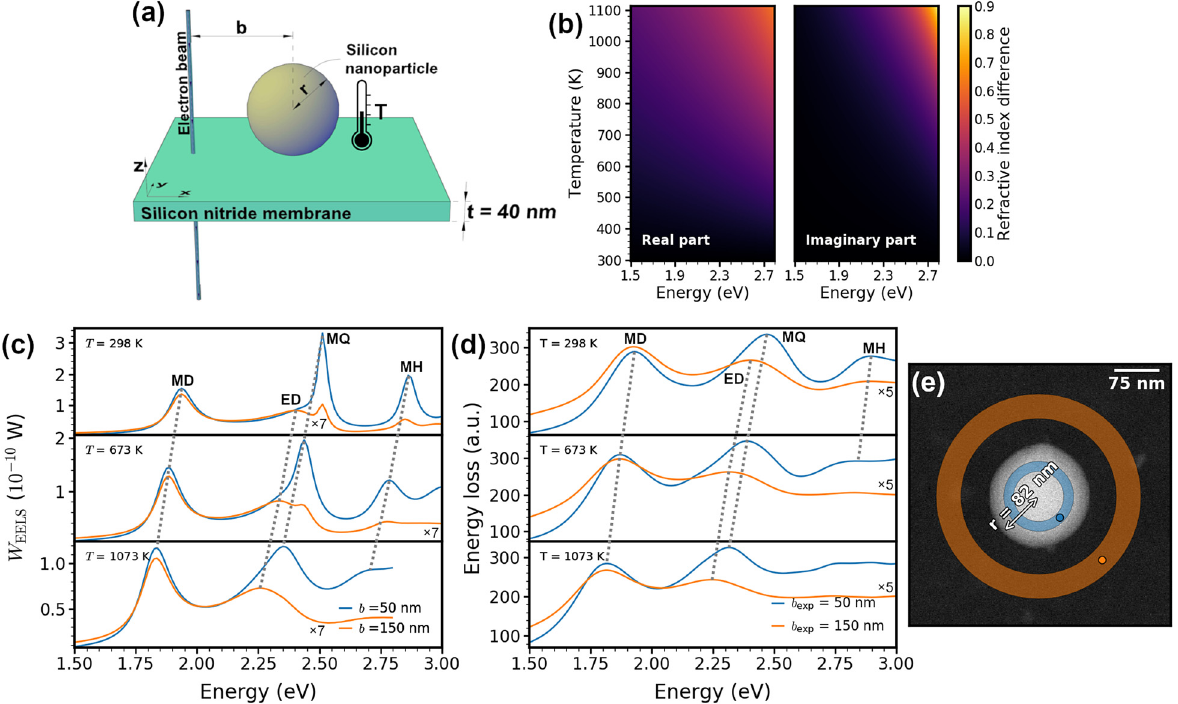
Figure 1: Thermal tuning of Mie resonances in silicon nanoparticles. (a) Schematic of a silicon nanoparticle of radius r placed on a silicon nitride membrane and excited by an electron beam. The impact parameter b denotes the distance between the electron beam and the center of the nanoparticle. The temperature is applied to the nanoparticle by a ceramic heater located around the nitride membrane. (b) Temperature modulation of the refractive index of silicon. (c) Simulated and (d) experimental EELS spectra of a silicon nanoparticle with a radius r = 82 . 4 ± 1 . 9 nm acquired from the electron beam positions shown in (e). (e) STEM image of the nanoparticle, where the colored areas represent the integration regions for the experimental EELS signal, and the colored points are the position of the electron beam in the